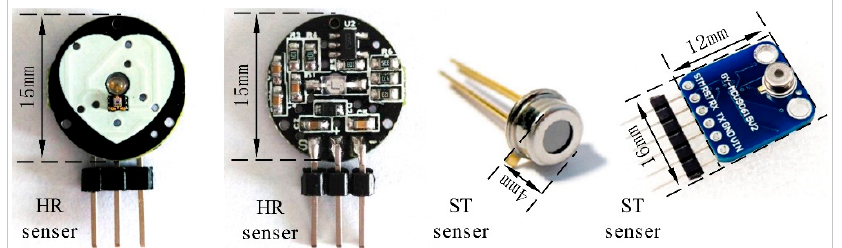
Figure 3. Photograph of heart rate (HR) and skin temperature (ST) sensor probe.